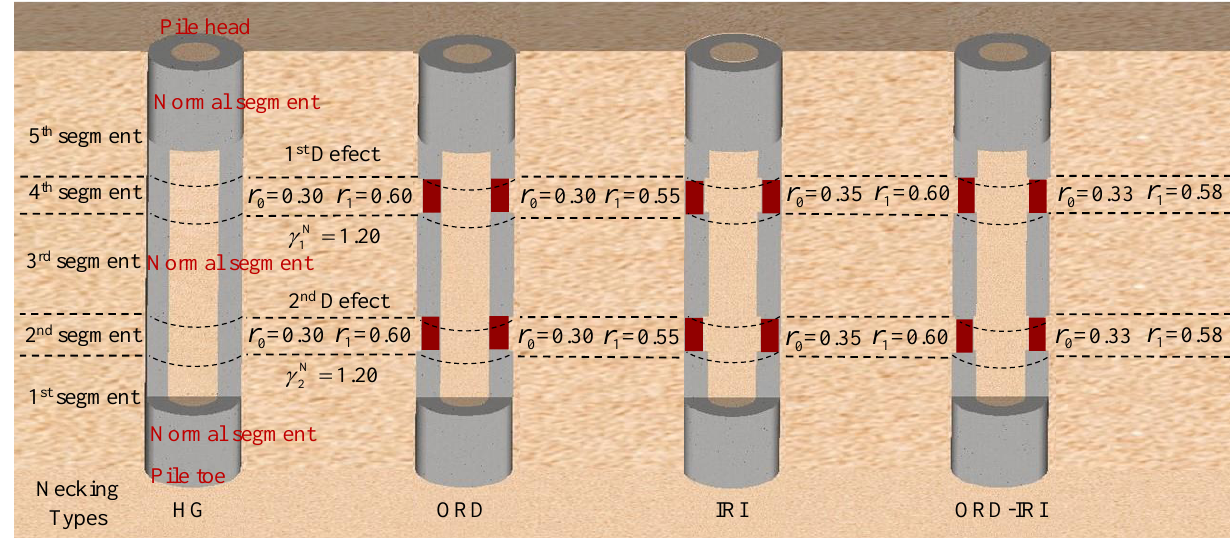
Figure 3. Different necking types of pipe piles.